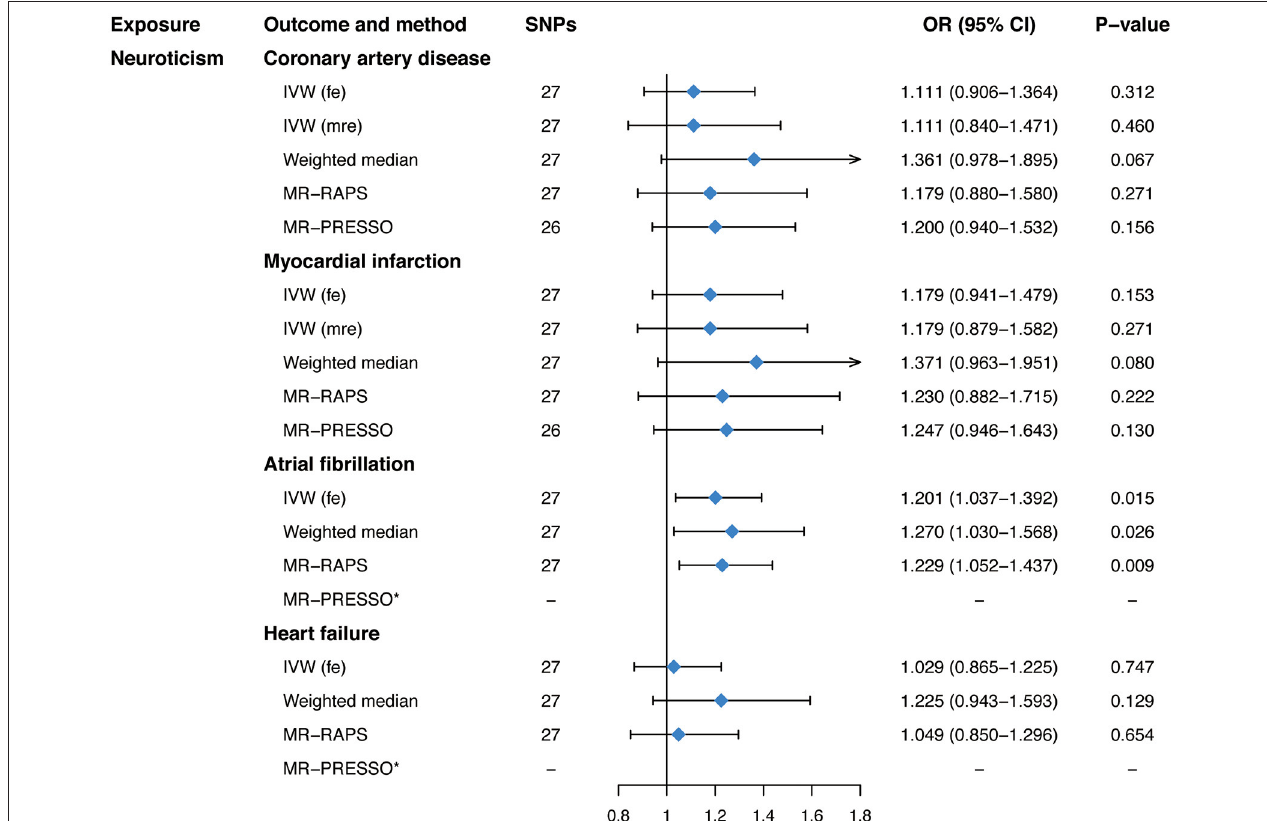
FIGURE 2 | Mendelian randomization estimates of genetically predicted neuroticism on four cardiovascular diseases. SNPs, single-nucleotide polymorphisms; OR, odds ratio; CI, confidence interval; IVW (fe), fixed-effects inverse-variance weighted; IVW (mre), multiplicative random-effects inverse-variance weighted; MR-RAPS, Mendelian randomization-robust adjusted profile score; MR-PRESSO, Mendelian randomization pleiotropy residual sum and